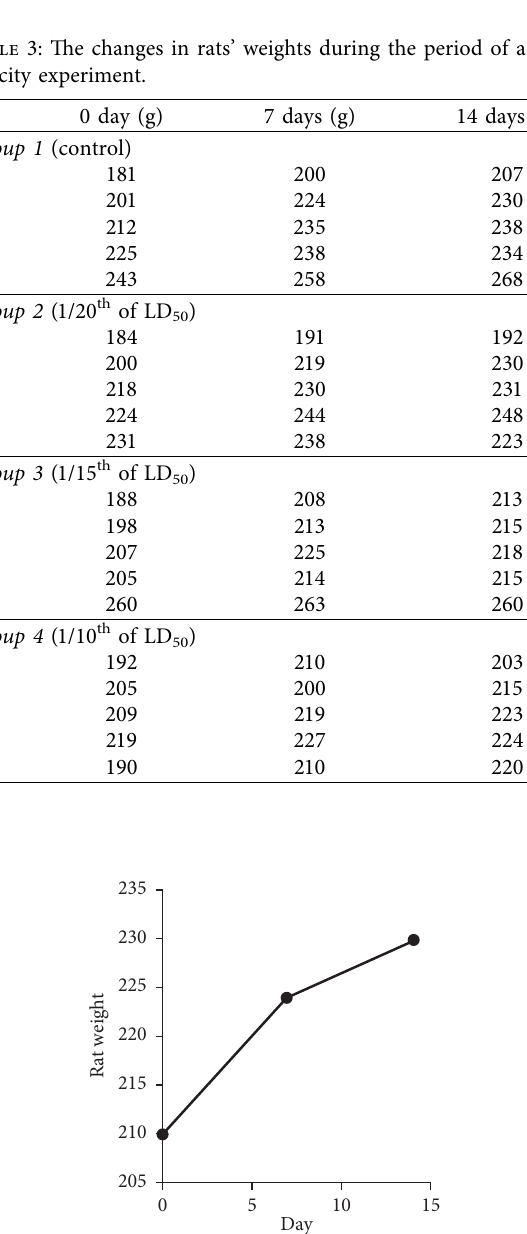
Figure 2: Illustrative relation of the weights of rats versus time based on the acute toxicity